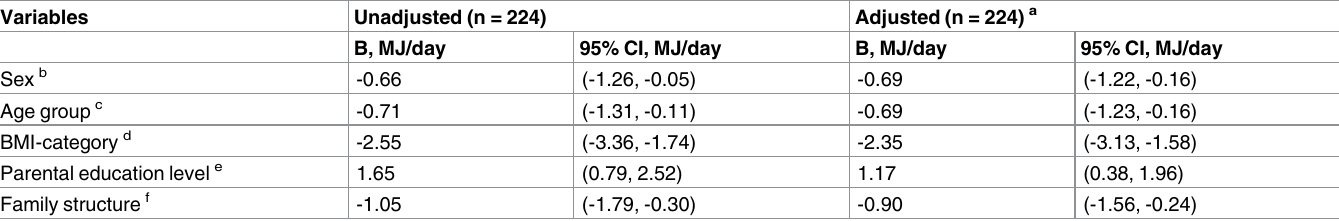
Table 2. Variables associatedwith misreporting of reported energy intake, defined as the difference between EI and TEE (EI minus TEE).